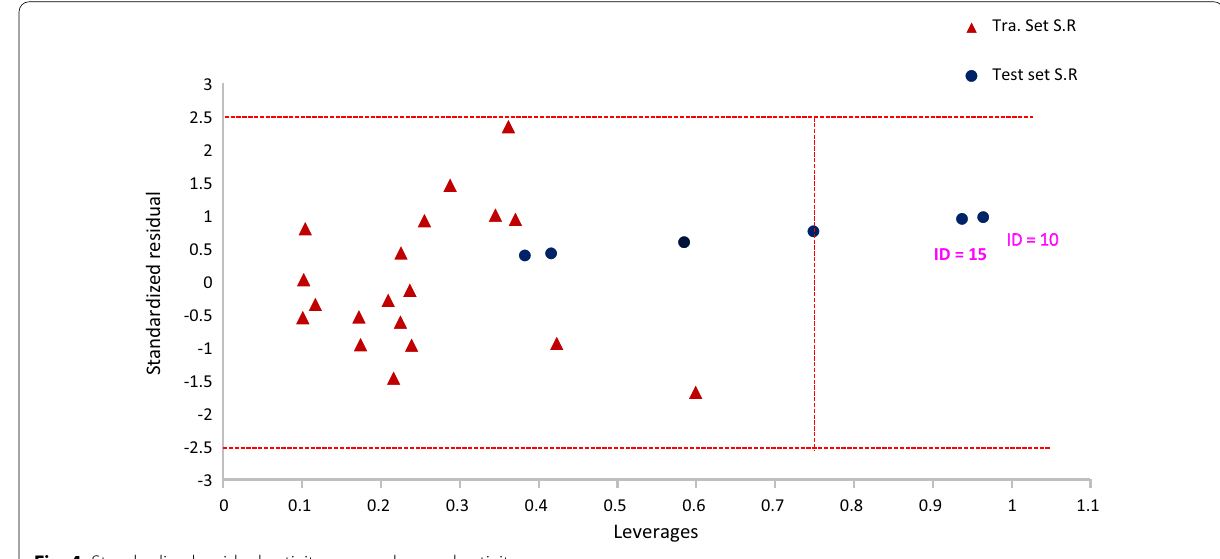
Fig. 4 Standardized residual activity versus observed activity